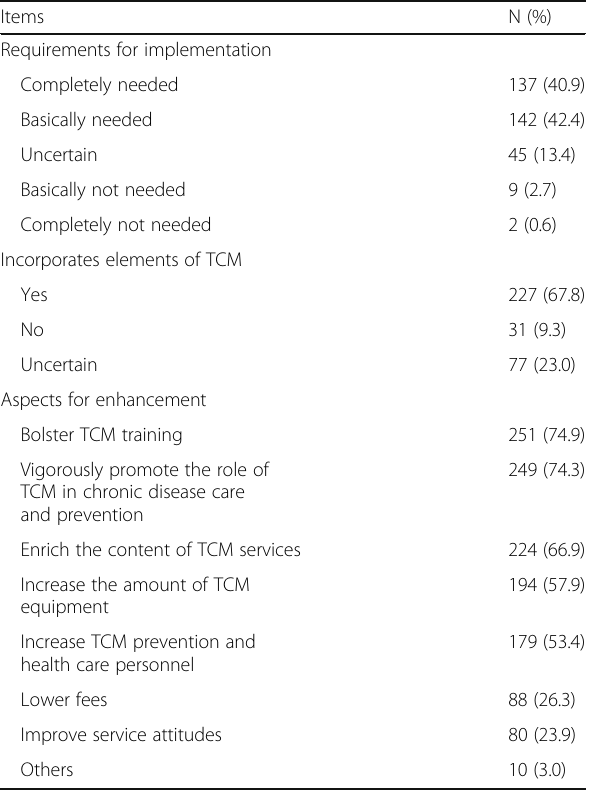
Table 3 Health care professionals ’ prevention and treatment practices in